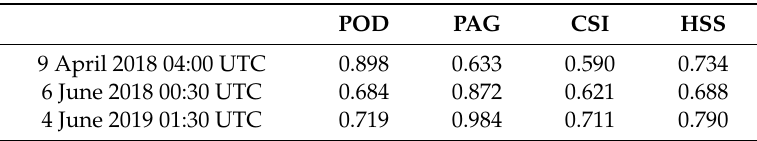
Figure 10. Sea fog and cloud mixtures. Results of the proposed sea fog detection algorithm on ( a ) 9 April 2018, at 04:00 UTC, ( b ) 6 June 2018, at 00:30 UTC, and ( c ) 4 June 2019, at 01:30 UTC. The green and cyan colors indicate the sea fog pixels obtained using only AHI 3.9 μ m and the BTD algorithm and only the proposed sea fog algorithm, respectively. The purple color indicates that both sea fog algorithms detected pixels as sea fog. Table 5. Statistical results for sea fog and cloud mixtures.